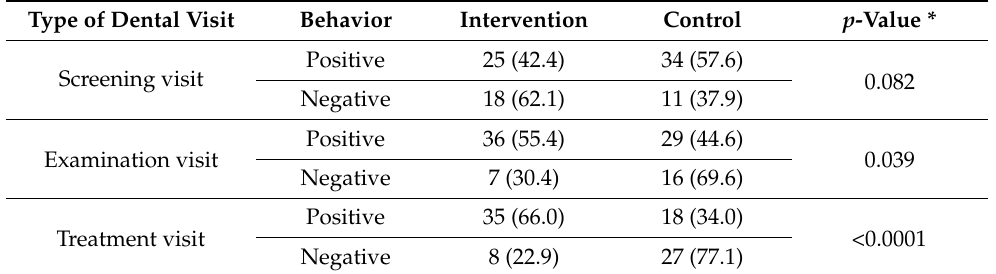
Table 8. Comparison of Frankl behavior ratings between groups at different visits.